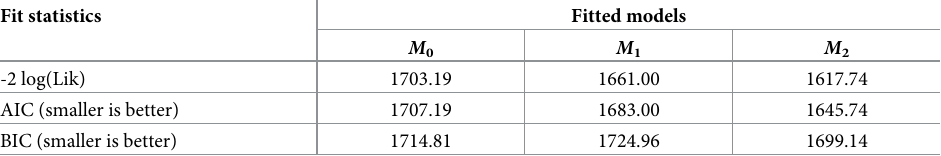
Table 2. Fit statistics for models with cluster-specific random effects b level predictors and b j ( M 1 ), and M 1 with cluster-specific predictors ( M 2